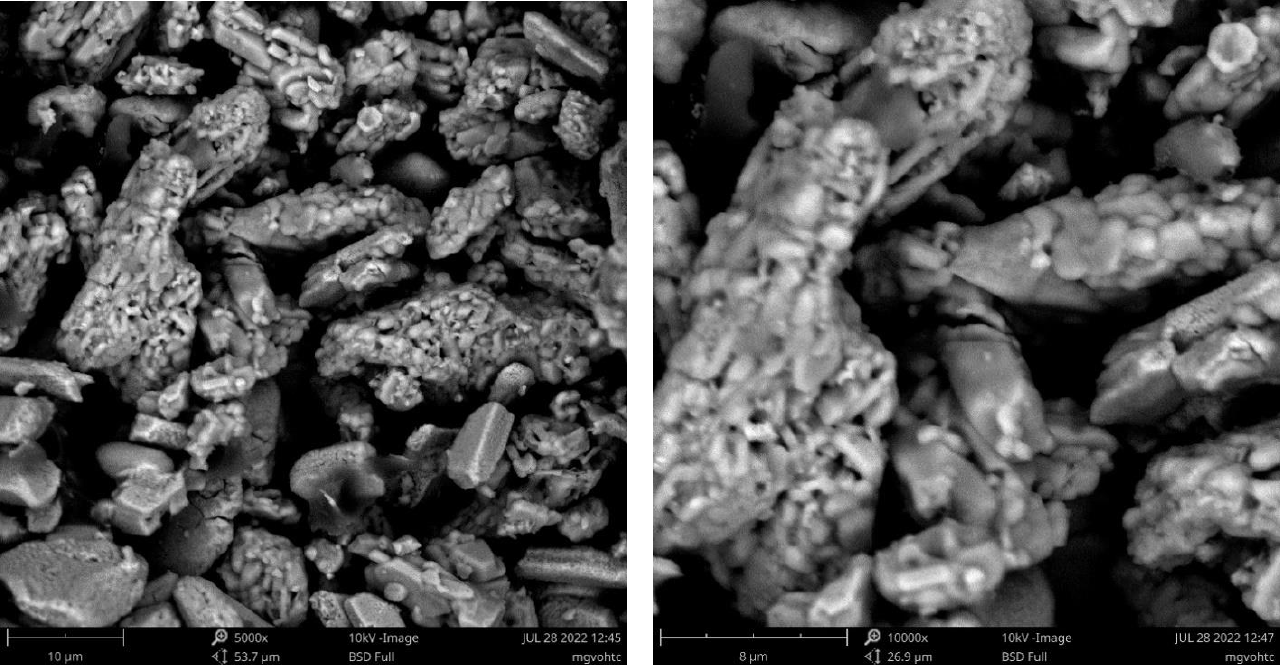
Figure 8. SEM micrographs of MgVO/C at different magnifications.